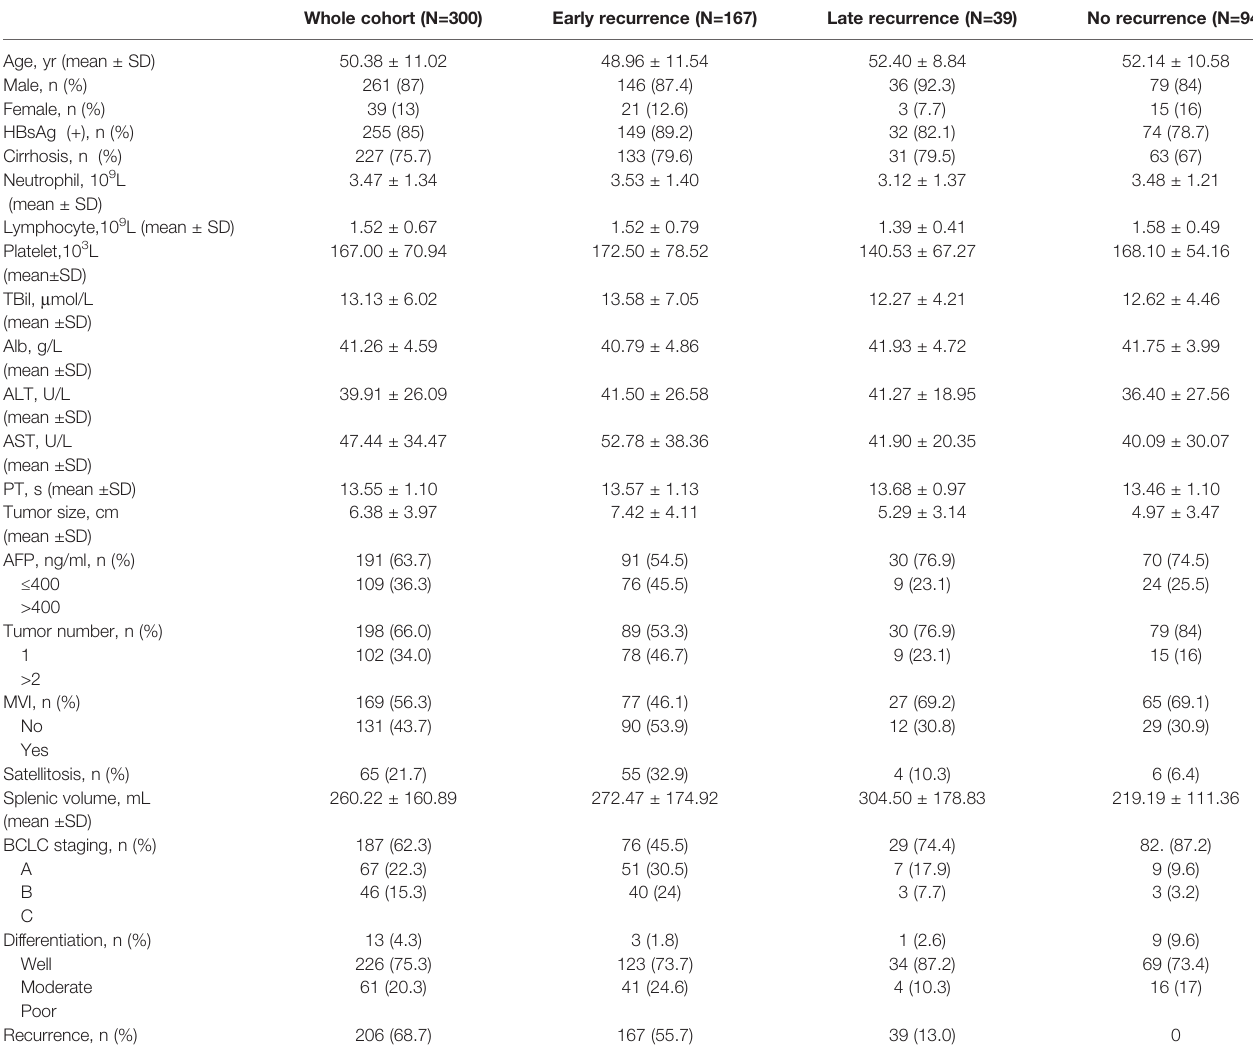
TABLE 1 | Demographics and clinical data of study